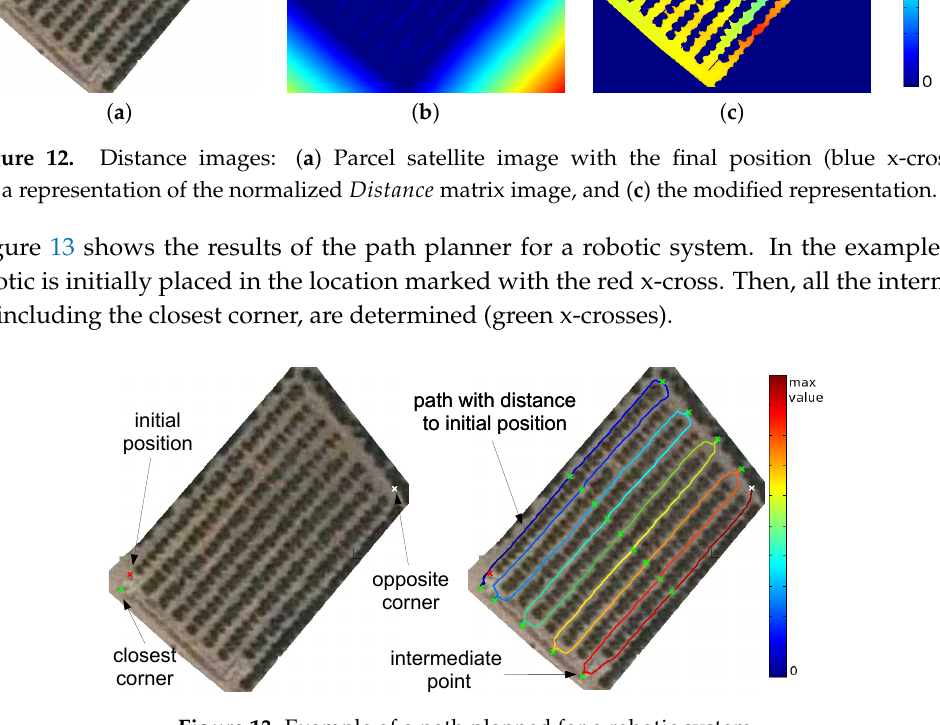
Figure 13. Example of a path planned for a robotic